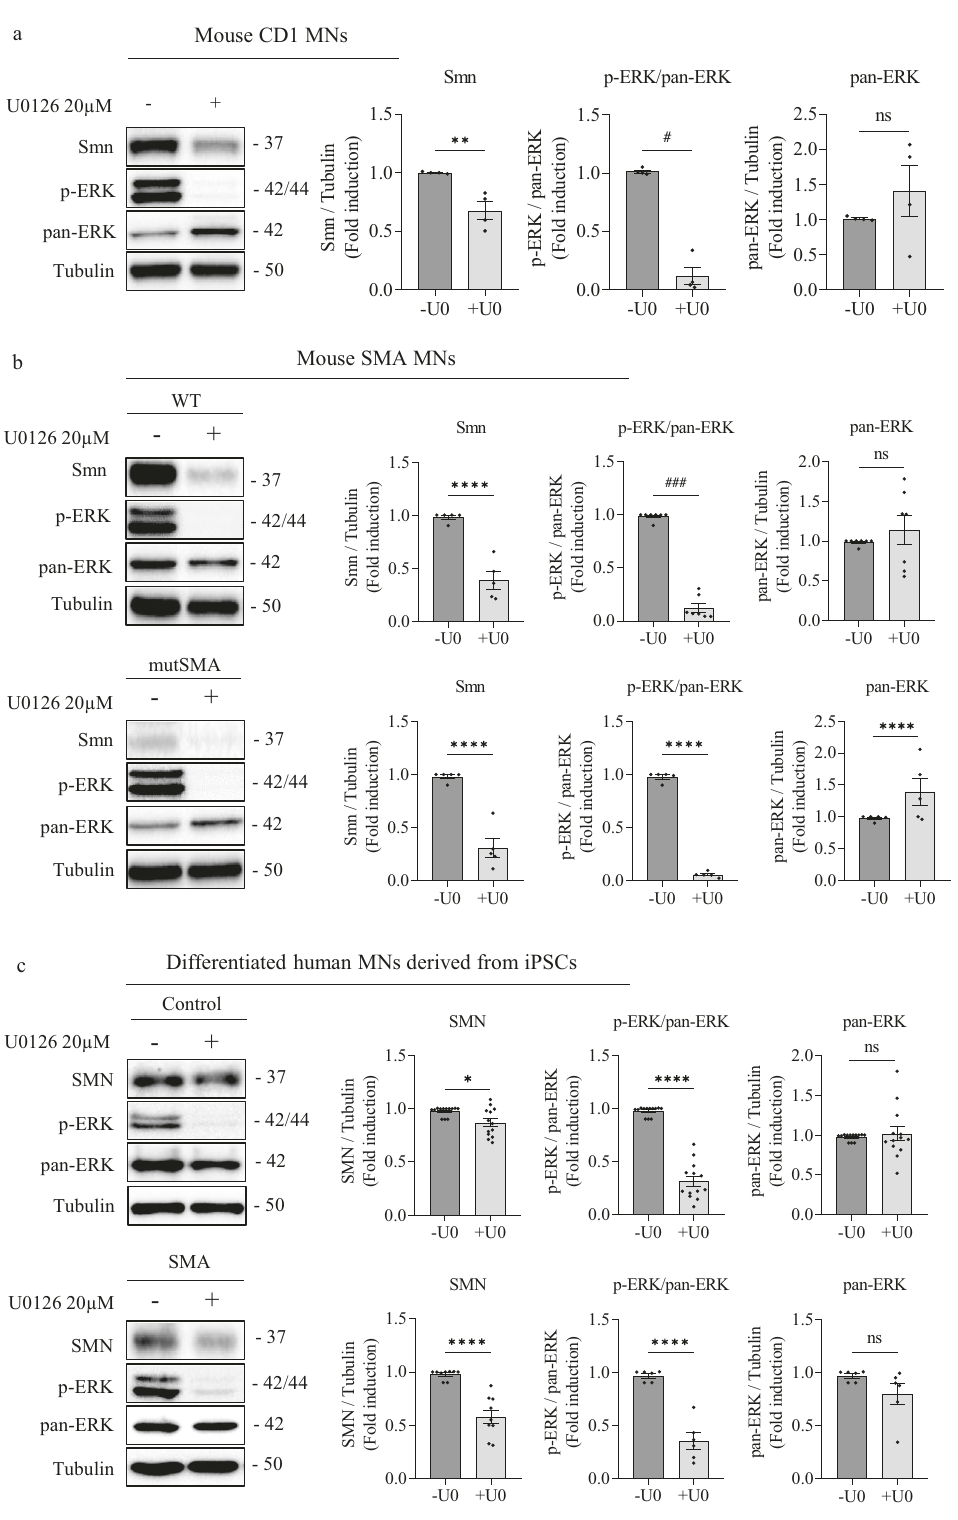
Fig. 2 ERK MAPK pathway regulates SMN protein level in MNs. a Six-day CD1 cultured MNs, b 6-day WT (left) and mutSMA (right) cultured MNs, and c 7-day differentiated Control (left) and SMA (right) human MNs were washed and treated with 20 μ M U0126 (U0) during 24 h or left untreated. Cell lysates were then obtained and submitted to western blot analysis using anti-phospho-ERK (p-ERK) or anti-SMN antibodies. Membranes were stripped and reprobed with anti-ERK (pan-ERK) antibody or with anti- α -tubulin antibody. Graphs represent the expression of Smn vs α -tubulin or p-ERK vs pan-ERK or pan-ERK vs α -tubulin, and correspond to the quanti fi cation of at least 4 independent experiments ± SEM. Symbols indicate differences using Student t test (** p < 0.01; **** p < 0.0001) or Mann-Whitney test ( # p < 0.05; ### p < 0.001).